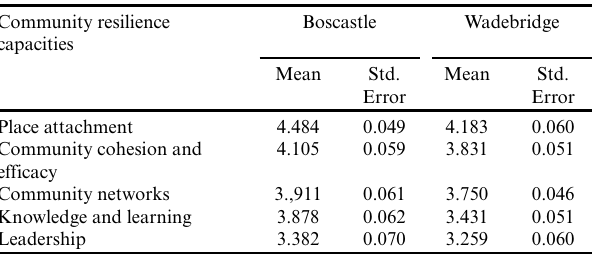
Table 4. Mean scores from resident survey showing perceived importance of community resilience capacities in Boscastle ( n = 70) and Wadebridge ( n = 100).